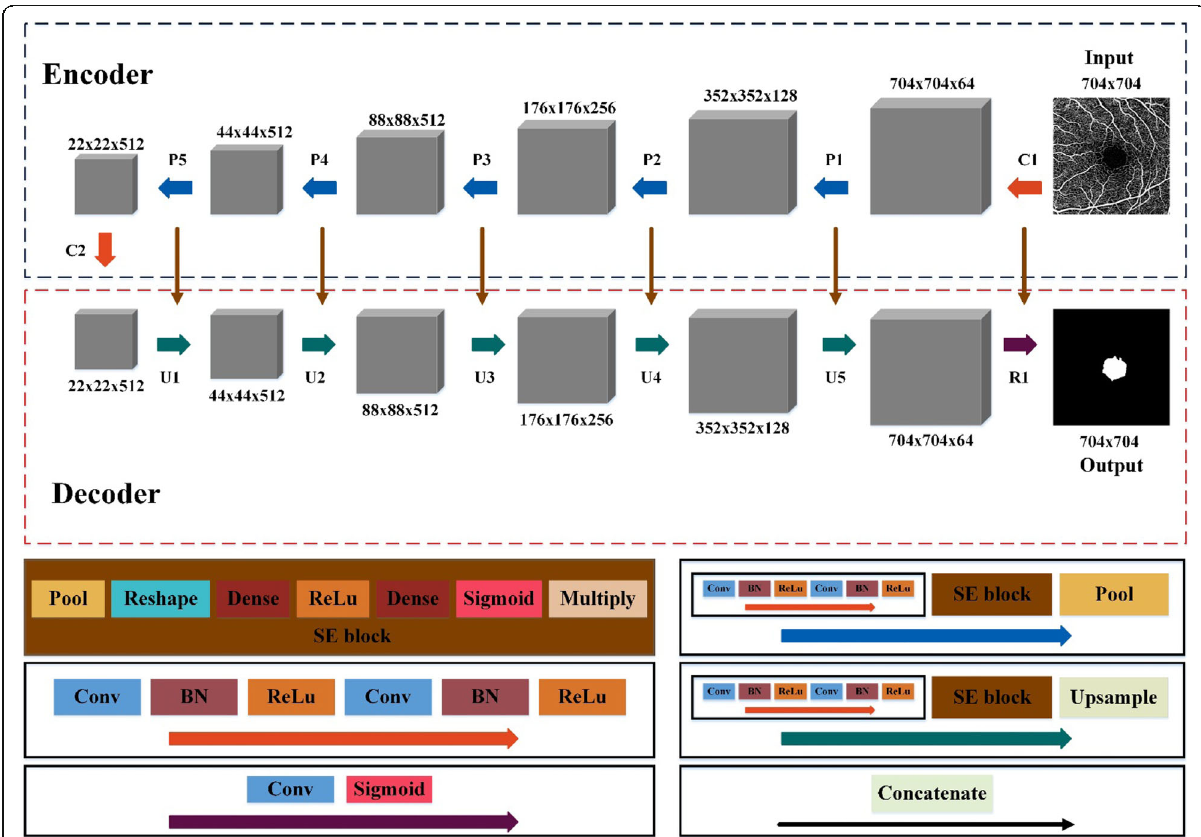
Fig. 3 Graphical representation of the proposed deep learning network. The proposed deep learning network included an encoder and decoder. The encoder comprised two Conv-BN- ReLu blocks (C1 – C2) and five pooling blocks (P1 – P5). The decoder comprised five upsampling blocks (U1 – U5) and a reconstruction block (R1). The output of each layer is a three-dimensional feature map of size (h × w × d), where h and w are the height and width of the feature map, respectively, and d is the feature